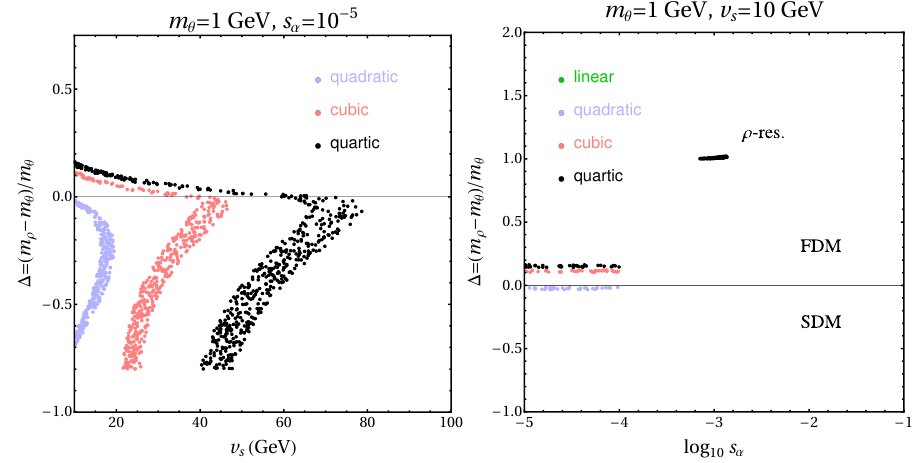
Figure 9. Scan in ∆ and v s ( s α ) with fixed m θ = 1 GeV and s α = 10 − 5 ( v s = 10 GeV) for the minimal models on the left (right) panel. Constraints from light scalars that mix the Higgs, Fermi-LAT and invisible Higgs decay have been taken into account. All the points fulfill the relic abundance condition 0 . 5 6 Ω / Ω 6 1 obs